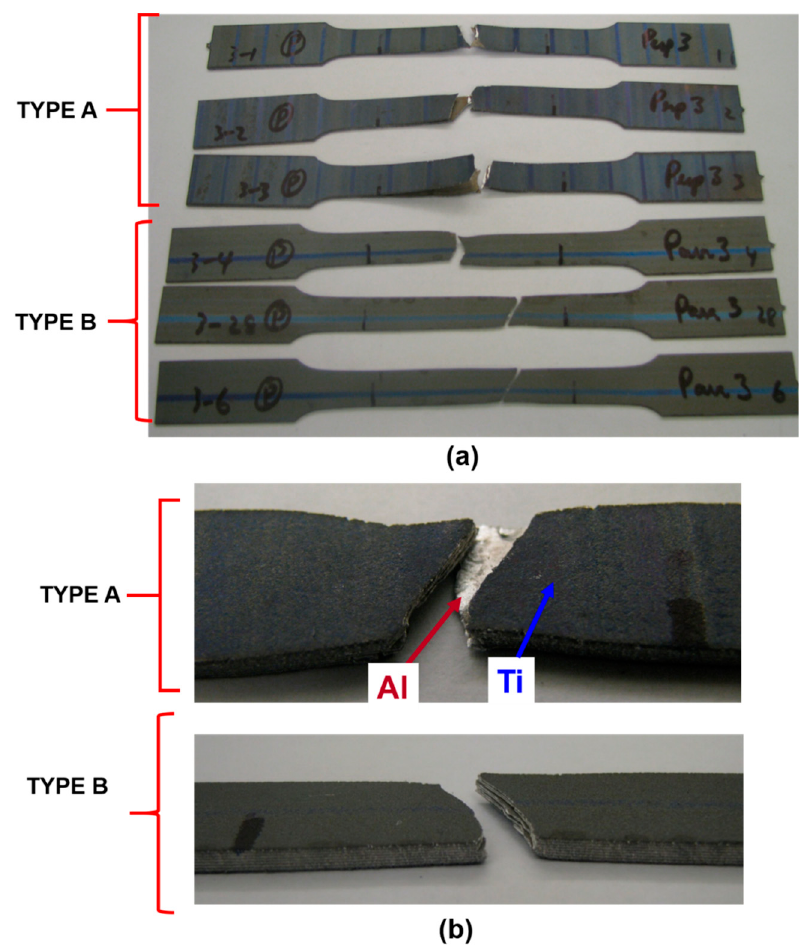
Figure 3. Different failure types observed after tensile tests performed at a strain rate of 0.0013/s at RT for ( a ) three bi-layered and ( b ) seven bi-layered samples.